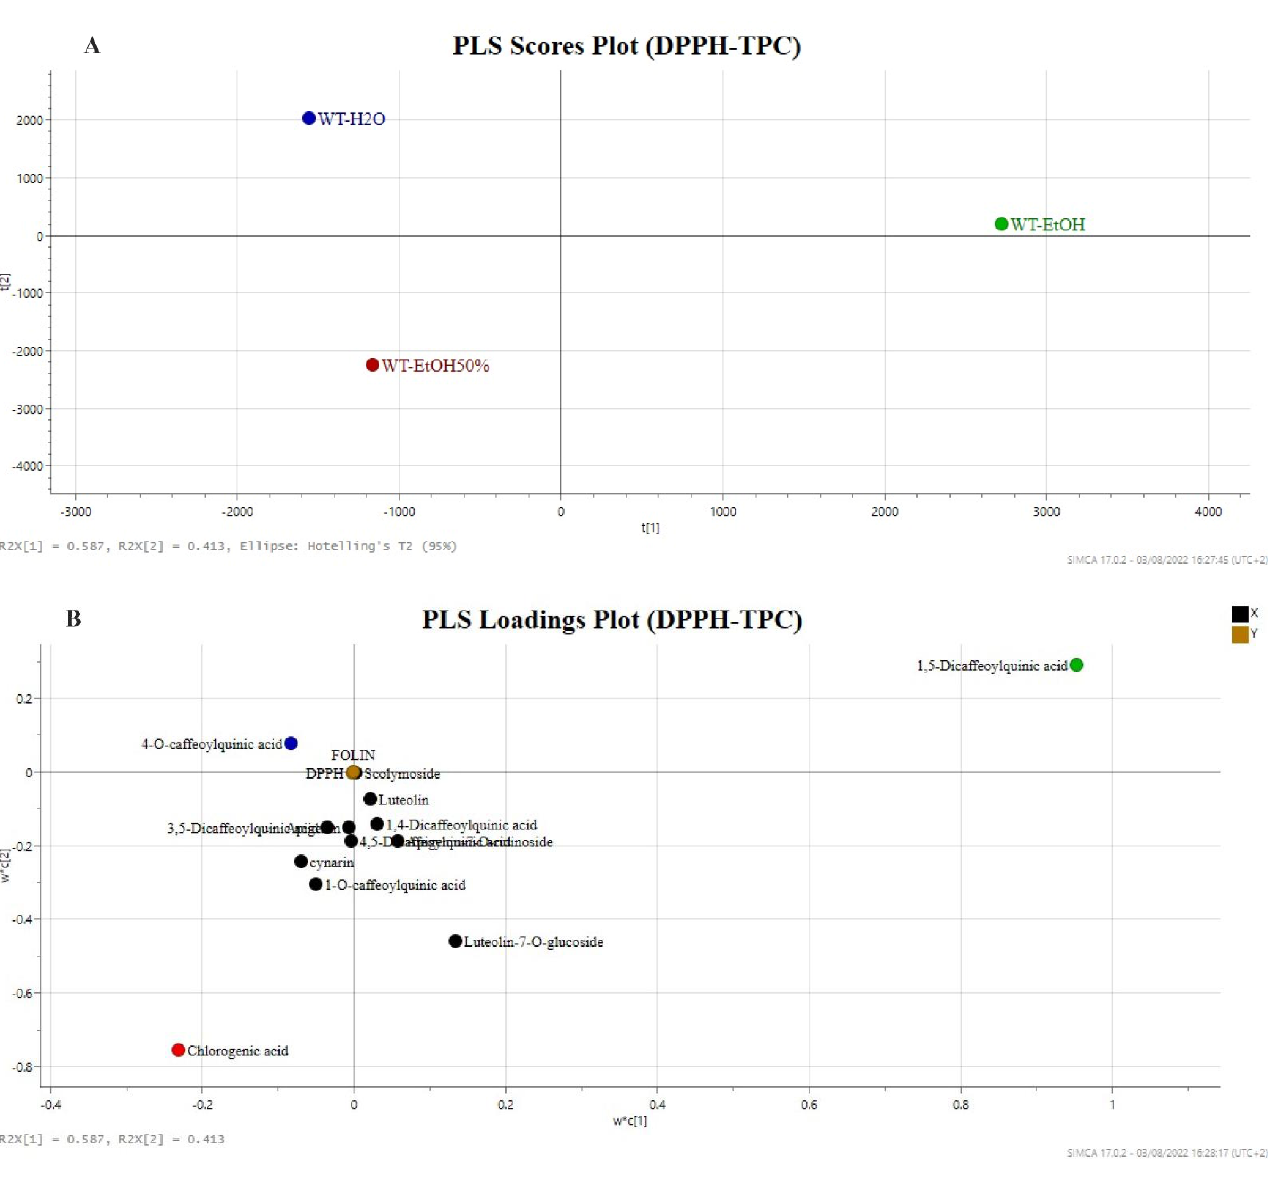
Figure 4. Supervised PLS regression plots of green extracts of C. cardunculus leaves. Scores plots ( A ) and loadings plots ( B ). WT_EtOH: ethanol extract of C. cardunculus wild-type; WT_H 2 O: water extract of C. cardunculus wild-type; WT_EtOH50%: ethanol/water (50% v / v ) extract of C. cardunculus wild-type.